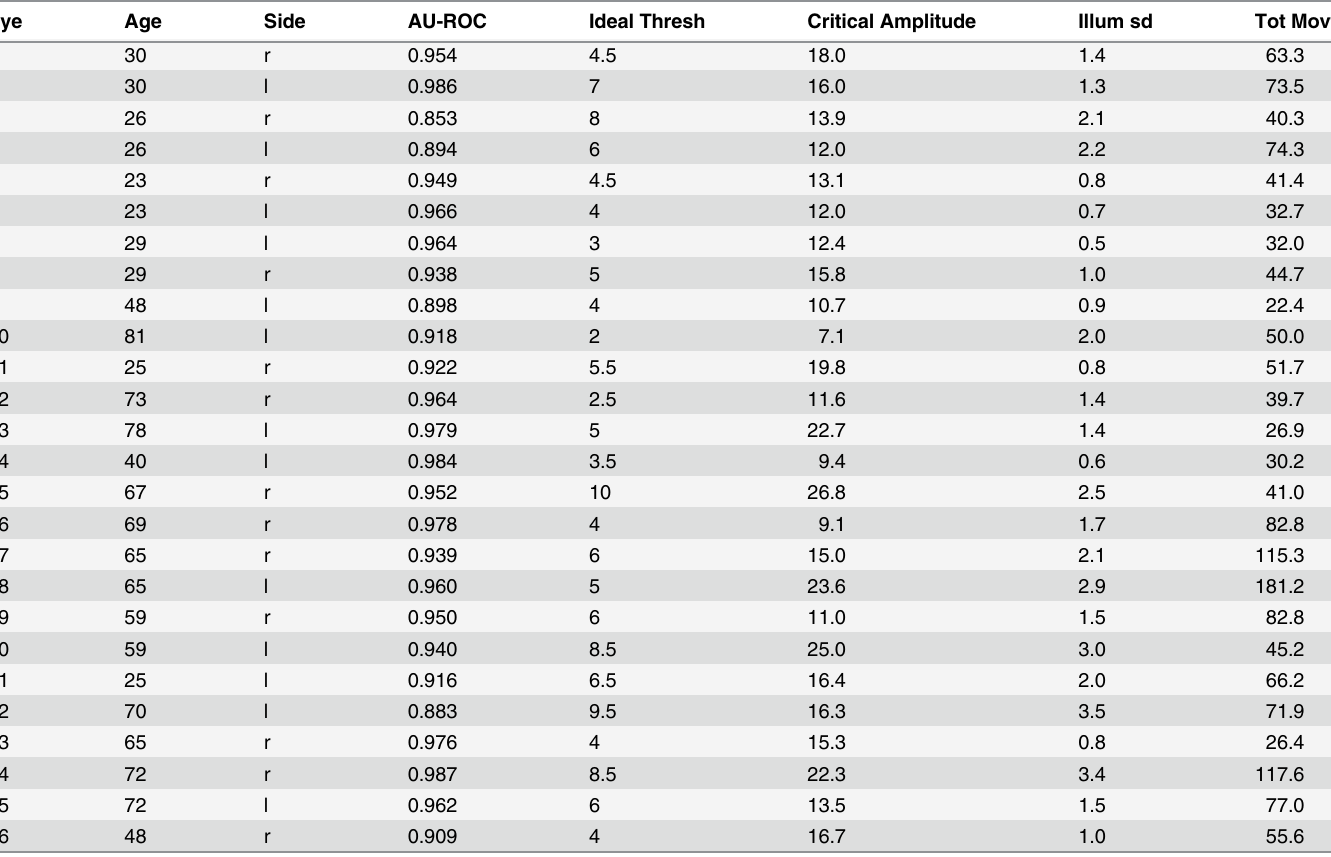
Table 1. Average values of key parameters for each eye: AU-ROC = area under the receiver operator characteristic curve, Ideal Thresh = ideal threshold, Illum sd = image illumination variation and Tot Movt = maximum frame movement during video of three cardiac